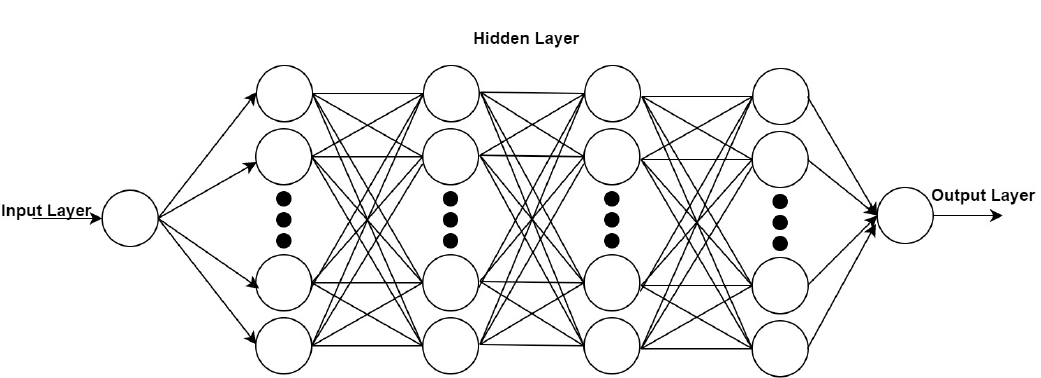
Figure 1. Multi-layer perceptron.